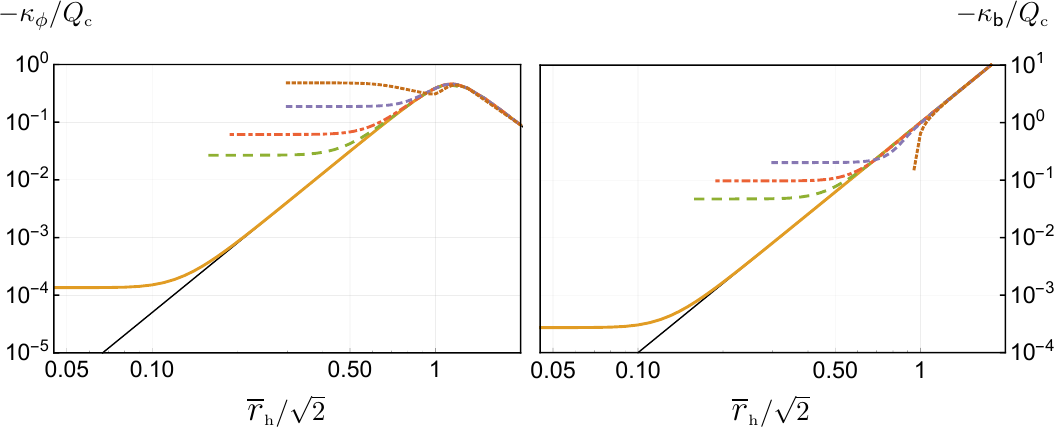
p 2 N (see legend in (cid:12)gure 4). q